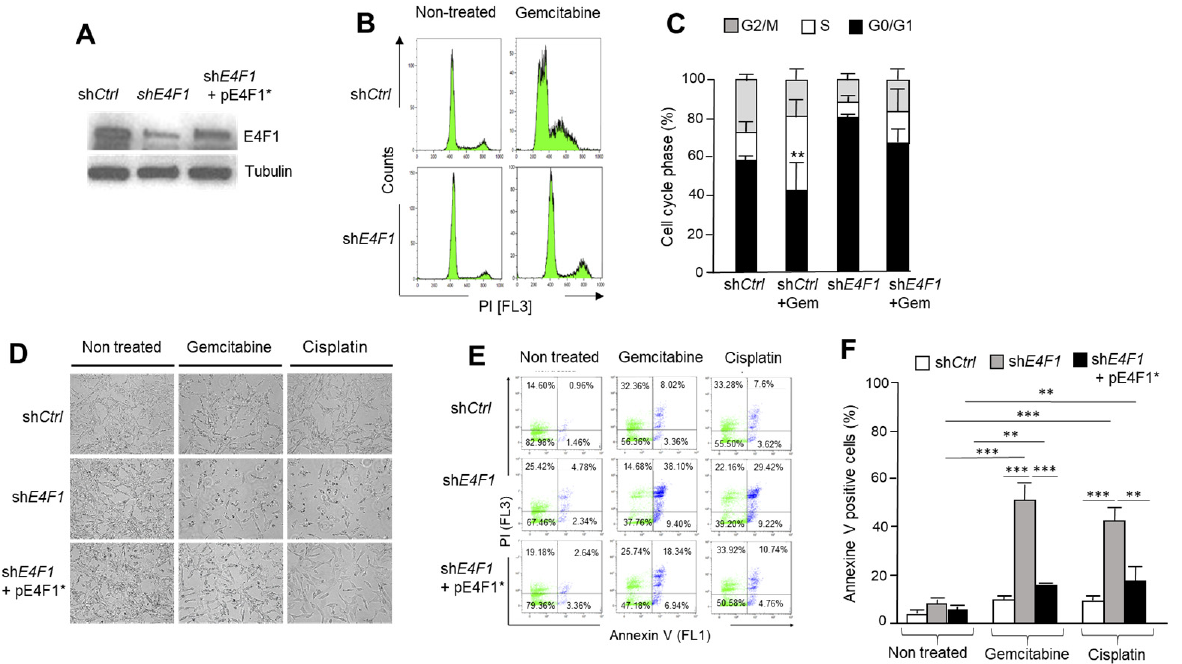
Figure 1. Depletion of the transcription factor E4F1 sensitizes SUM159 Human Triple-Negative Breast Cancer (TNBC) cell line to the chemotherapy drugs Gemcitabine and Cisplatin. ( A )—Deple- tion of E4F1 in SUM159. Immunoblot analysis of E4F1 protein level in protein extracts prepared